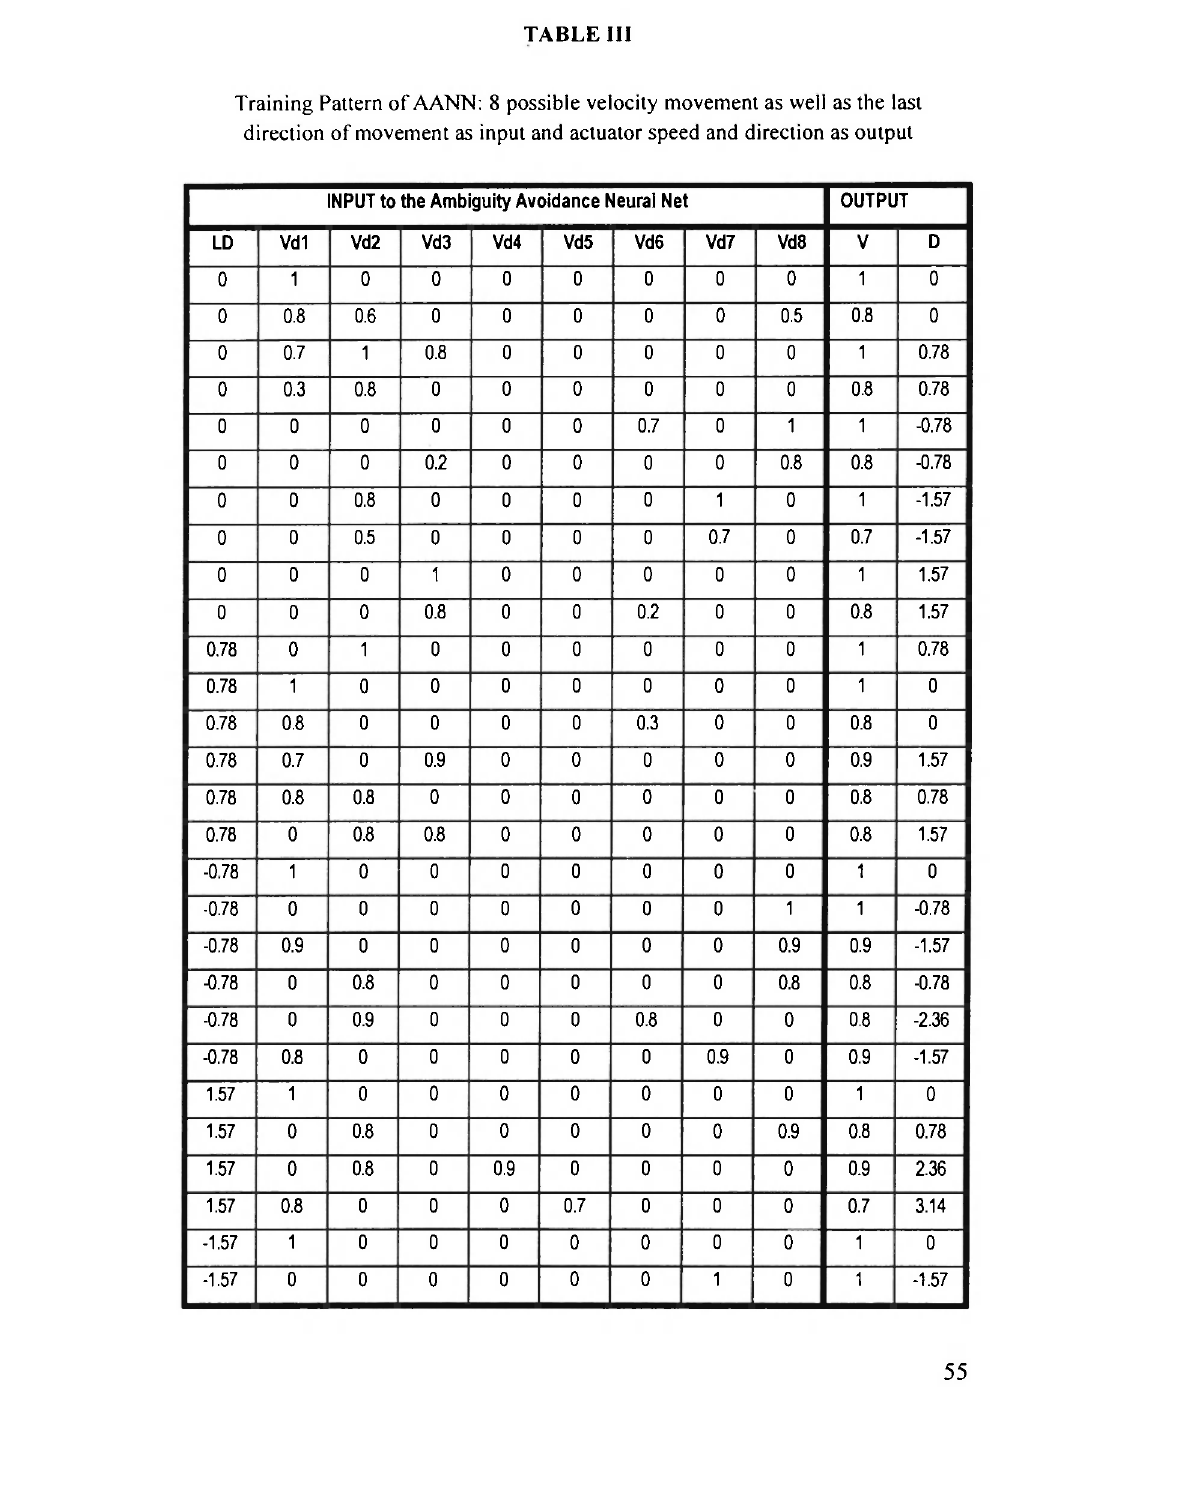
INPUT to the Ambiguity Avoidance Neural